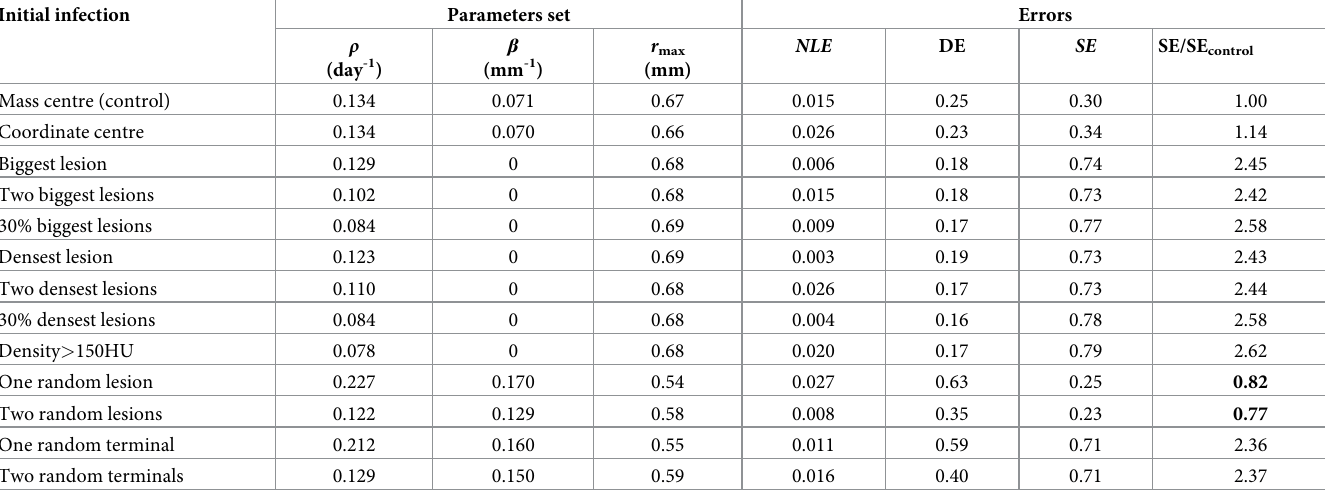
Table 6. Initial configurations explored with the model using experimental data.